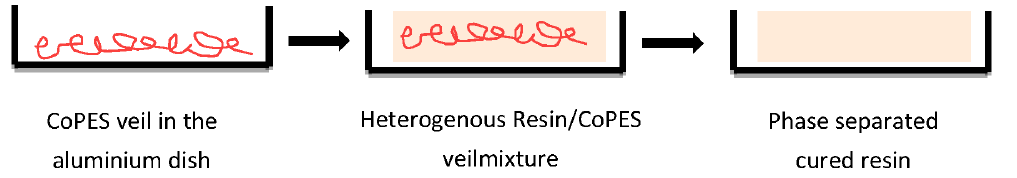
Figure 3. Schematics of soluble veil preparation route for neat resin samples.